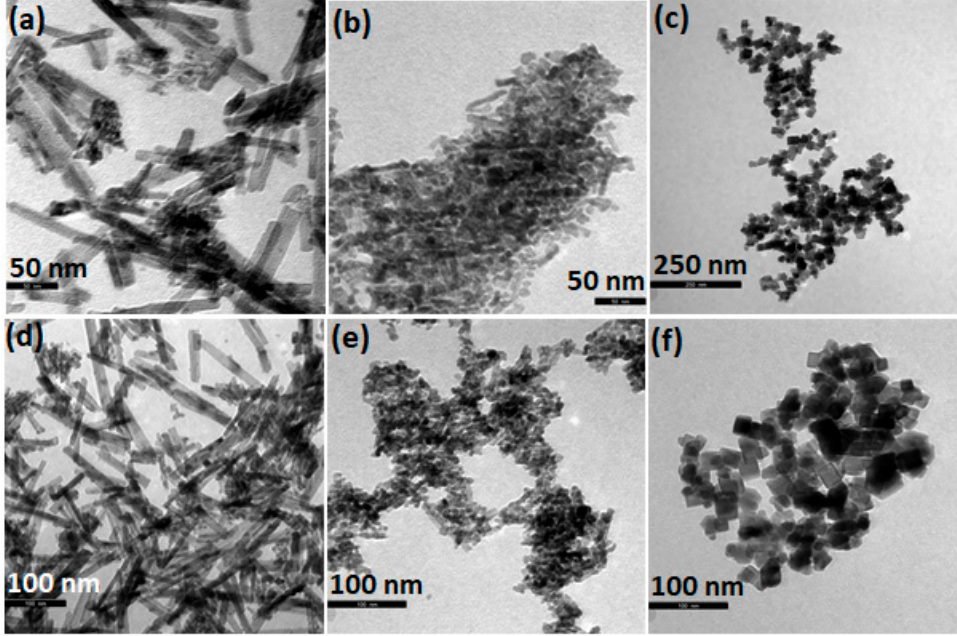
Figure 3. Indicative transmission electron microscopy (TEM) images of ceria ( a , d ) nanorods, ( b , e ) nanopolyhedra, and ( c , f ) nanocubes. Table 2. Textural, structural and redox properties of bare ceria